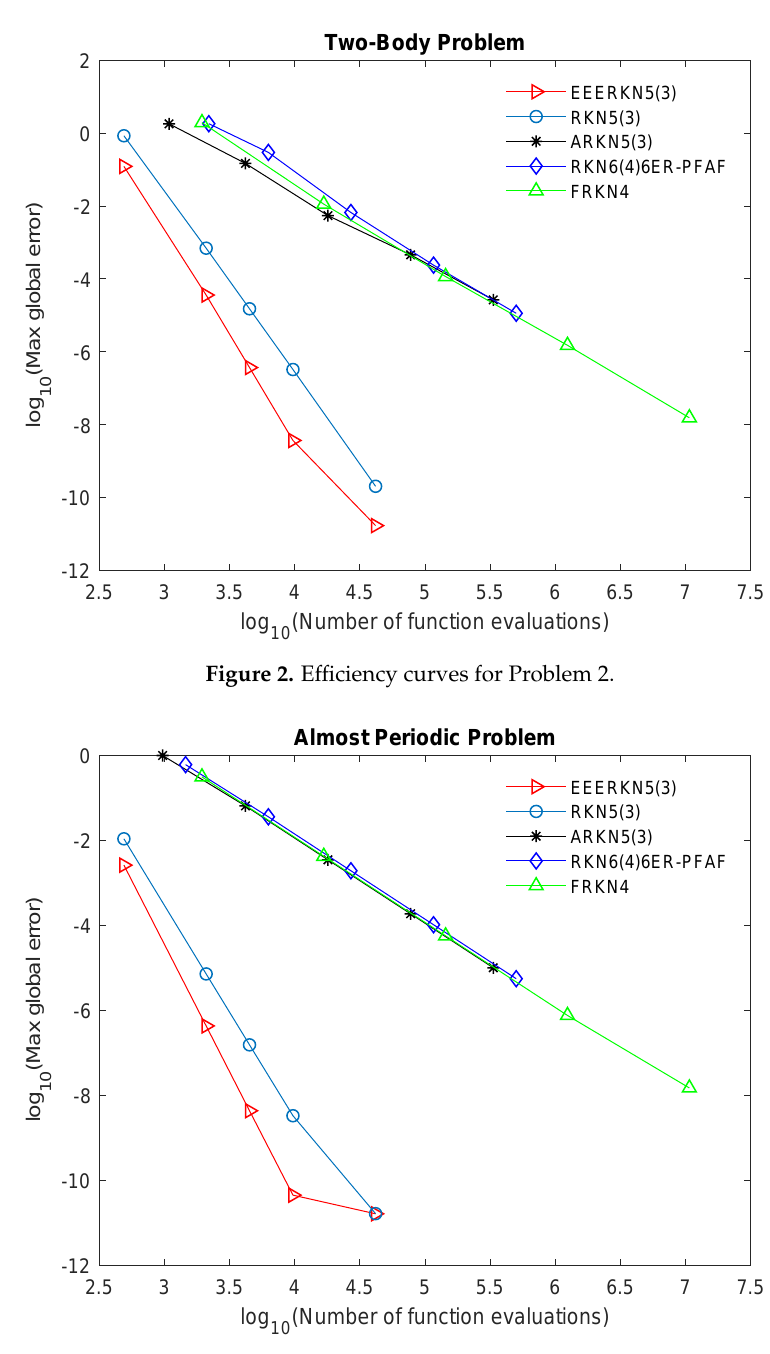
Figure 3. Efficiency curves for Problem